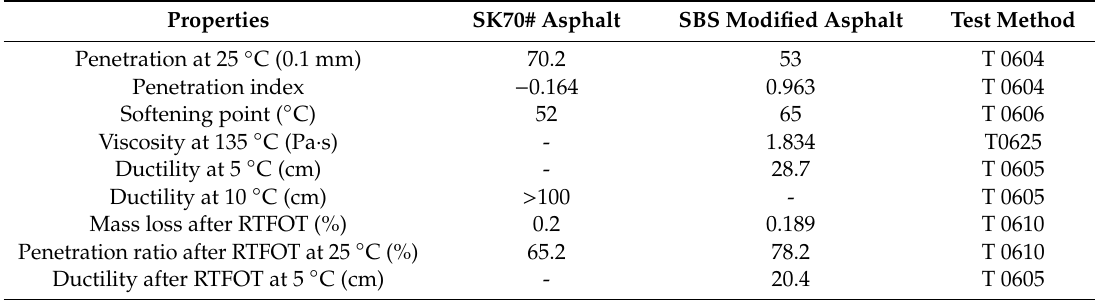
Table 6. Properties of SK70# asphalt and SBS modified asphalt.